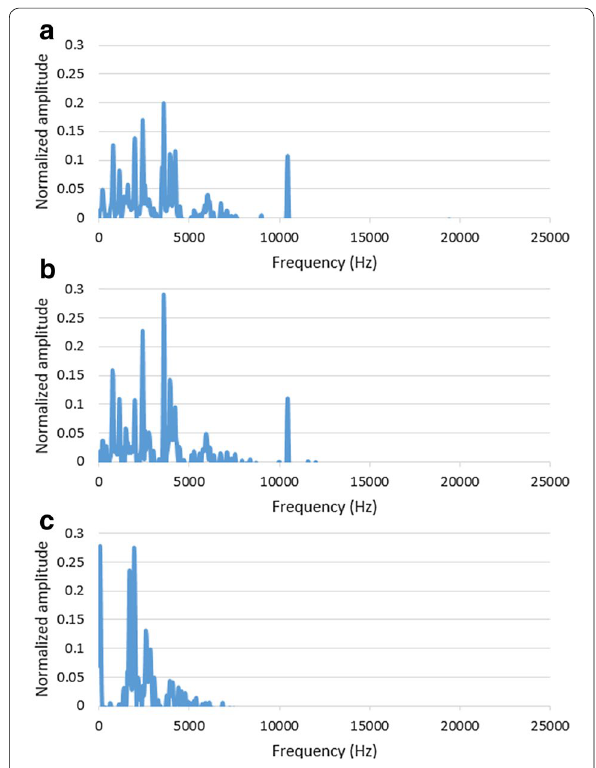
Fig. 9 Fourier spectrums of a the computed model, b a non-defec- tive sample and c a defective sample from the 15° delamination test block. The model’s spectrum bears more similarities to the non- defective spectrum than to the defective spectrum: the correlation distance between the model and the non-defective sample was 0.10 whereas it was 0.33 for the defect sample